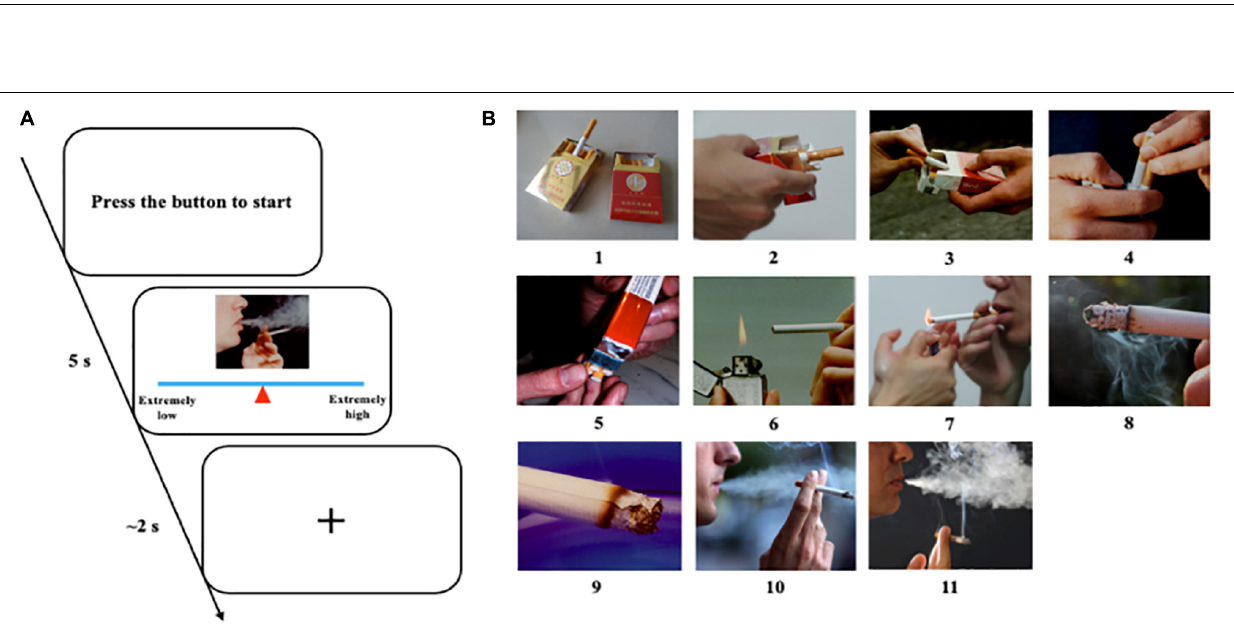
FIGURE 2 | Evaluation of nicotine related cues. (A) Picture evaluation protocol and procedure. Participants pressed the button to start a new trial. They had 5 s to move the mouse to change the position of the triangle on the line to give an appropriate score according to their craving to this picture. Then, they had about 2 s to rest and wait for the next trial. (B) Eleven selected pictures listed in ascending order of craving